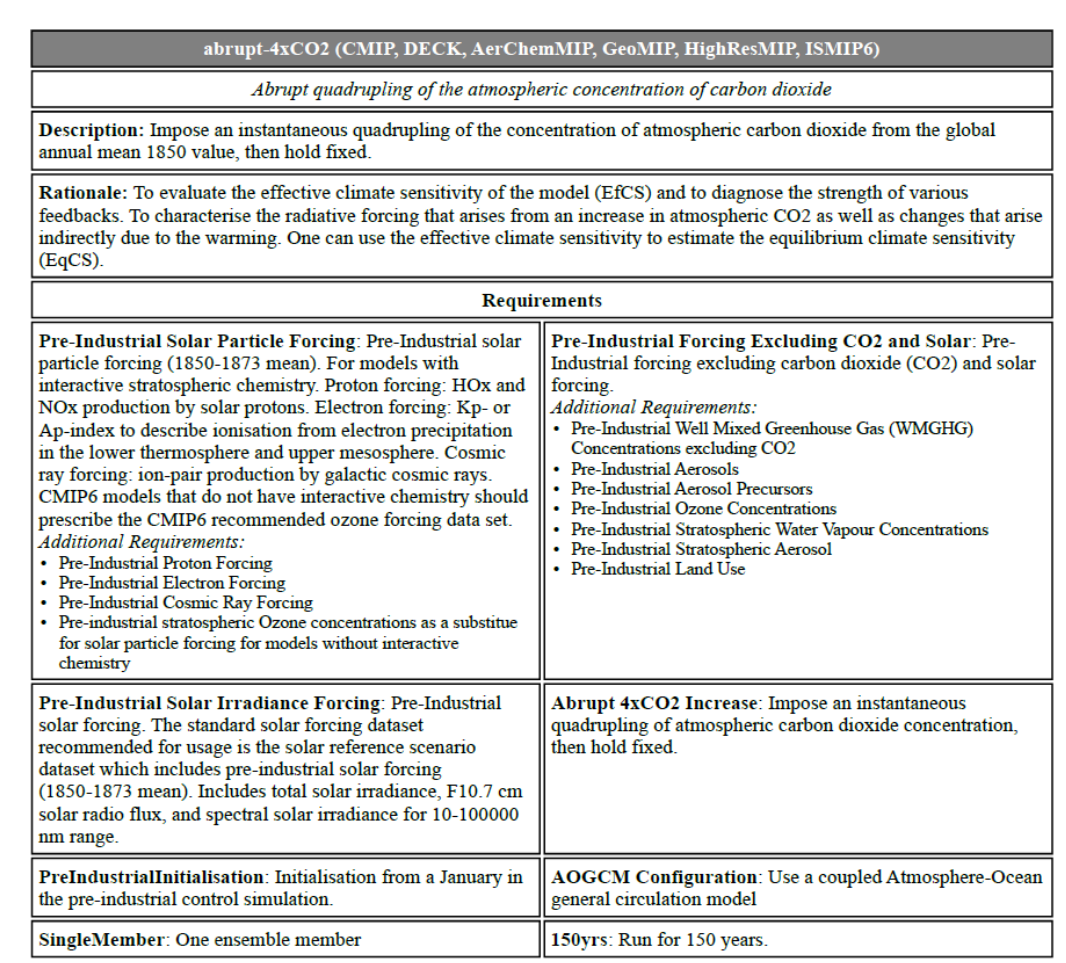
Table A1. The abrupt 4XCO 2 experiment is integral to a number of MIPs. (Not all properties are shown; see